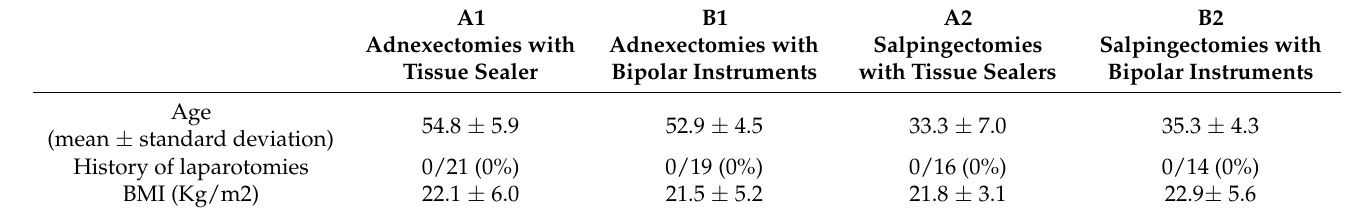
Table 1. Baseline characteristics of women undergoing laparoscopic interventions by